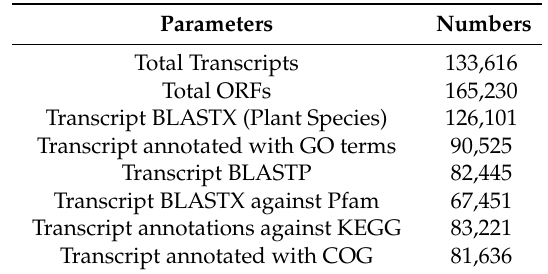
Table 2. Annotation summary of A. marmelos leaf transcripts. COG: cluster of orthologous groups, GO: gene ontology, KEGG: Kyoto Encyclopedia of Genes and Genomes, ORFs: open reading frames, Pfam: protein